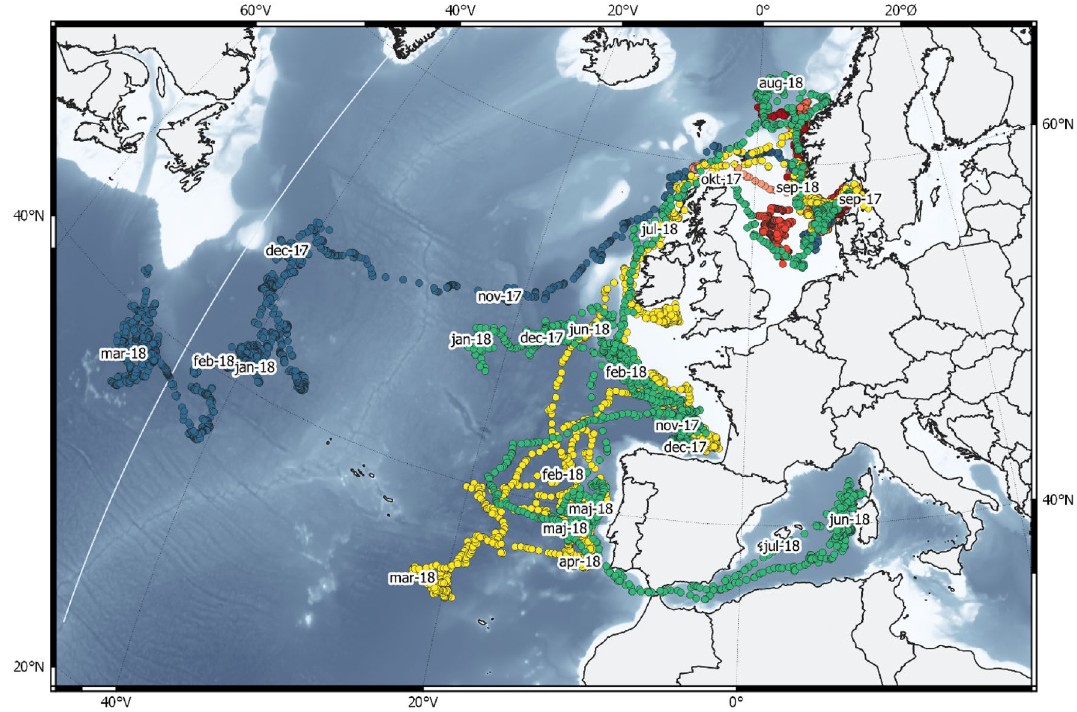
Figure 3. Estimated trajectories and pop-off locations for the 11 fish that yielded usable data. Trajectories of three fish with tag attached for more than seven months are coloured in blue (34861), yellow (34840) and green (34859). Trajectories of the remaining eight fish are coloured in shades of red. On each track mid-month positions are shown denoted by month-y. White dashed line indicates the ICCAT stock delimitation